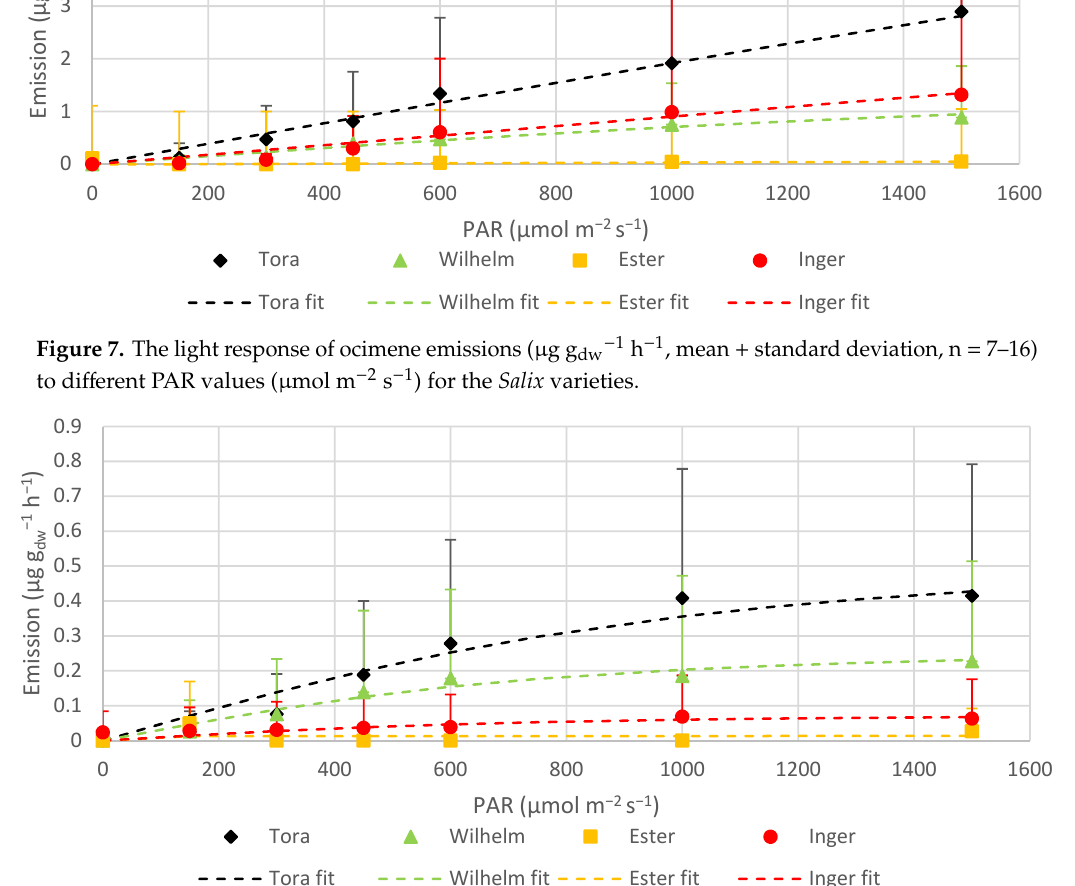
Figure 8. The light response of linalool emissions (µg g dw − 1 h − 1 , mean + standard deviation, n = 7–16) to different PAR values (µmol m − 2 s − 1 ) for the Salix varieties.